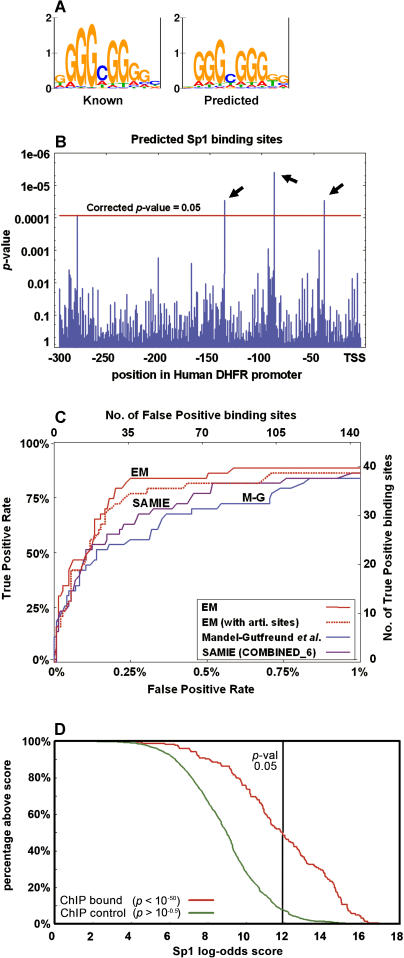
Validation of DNA-Recognition Preferences(A) The predicted binding site model of human Sp1 protein is compared to its known site (matrix V$SP1_Q6 from TRANSFAC [2], based on 108 aligned binding sites). To prevent bias by known Sp1 sites in our training data, the set of DNA-recognition preferences was estimated from the TRANSFAC data after removing all Sp1 sites.(B) Scanning the 300-bp-long promoter of human dihydrofolate reductase (DHFR) by the predicted Sp1 binding model. The p-value of each potential binding site is shown (y-axis). Four positions achieved a significant p-value (higher than the horizontal red line), out of which three are known Sp1 binding sites [41] (arrows).(C) A summary of in silico binding experiments for 21 pairs of Zinc Finger transcription factors and their target promoters. Shown is the tradeoff between false positive rate (x-axis) and true positive rate (y-axis) as the significance threshold for putative binding sites is changed. For every threshold point, our set of recognition preferences (EM) achieves better accuracy than the preferences of Mandel-Gutfreund et al. [5] (M-G) and Benos et al. [15] (SAMIE). Interestingly, when the DNA-recognition preferences were estimated from training data expanded to include TRANSFAC's artificial sequences, inferior results were obtained (dotted red line).(D) Cumulative distribution of Sp1 scores among the sequences of targets/non-targets of unbiased chromatin immunoprecipitation scans of human Chromosomes 21 and 22 [16]. The predicted Sp1 motif appears in 45% of the experimentally bound sequences but in only 5% of the control sequences.